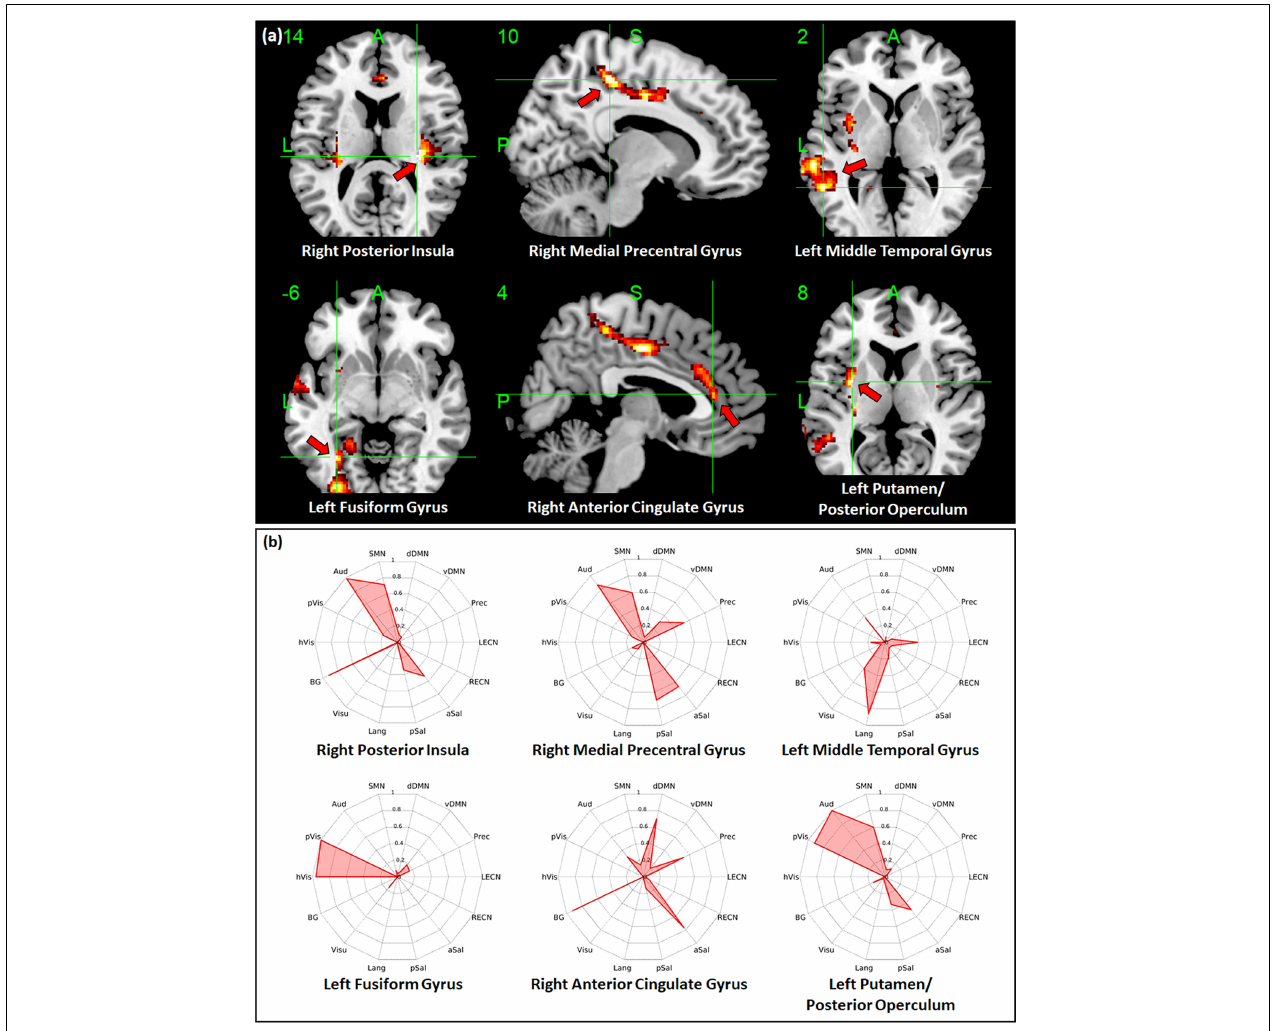
FIGURE 4 | Relationship between short-range intrinsic connectivity contrast (ICC) values and age. (a) Regions with short-range ICC values that showed significant (FWEc p < 0.05, CDT p = 0.001) negative linear relationship with age. (b) Spider plots of the overlap ratio quantifying the connection between the 14 canonical resting state networks and the regions shown in (a) . dDMN, dorsal default mode network; vDMN, ventral default mode network; Prec, precuneus network; LECN, left executive control network; RECN, right executive control network; aSal, anterior salience network; pSal, posterior salience network; Lang, language network; Visu, visuospatial (dorsal attention) network; BG, basal ganglia network; hVis, high visual network; pVis, primary visual network; Aud, auditory network; SMN, sensorimotor network; R, right; L,